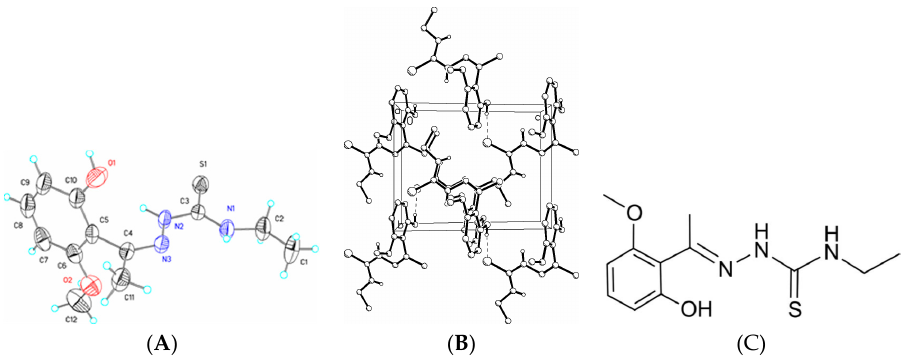
Figure 6. ( A ) ORTEP drawing of ( 6 ) showing the atom numbering scheme and 50% probability displacement ellipsoids of non-H atoms; ( B, C ) The molecular packing of ( 6 ) viewed along the b axis. Dashed lines indicate weak O–H … S intermolecular interactions. Hydrogen atoms not involved in hydrogen bonding have been removed for clarity. Table 5. Selected crystal and DFT* bond lengths (Å), bond angles (°), and torsion angles (°): ( 5 )–( 6 ). Atoms Distance, Å DFT, Å